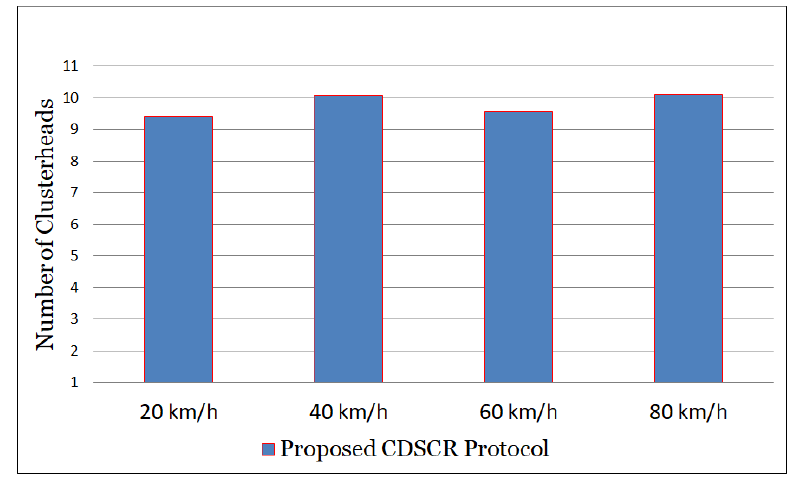
Figure 7. Number of cluster heads versus node mobility.